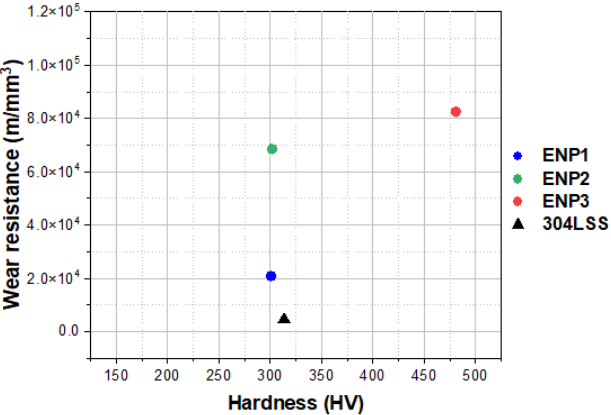
Figure 9. Wear-resistance versus hardness of the ENP duplex coatings and 304 L SS reference material at 10N load after 12,000 cycles.